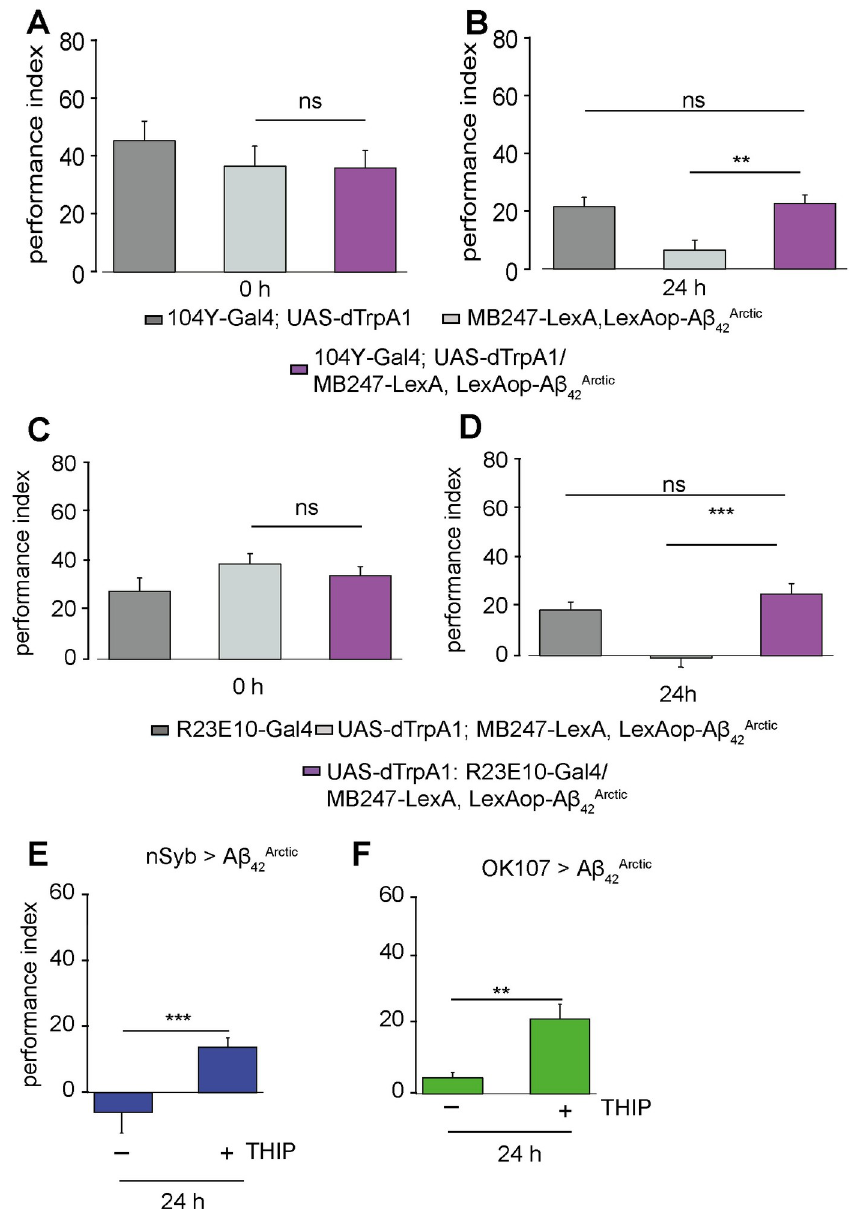
Fig 4. Artificial induction of sleep restores memory impairment in A β 42Arctic expressing flies. (B, D) Flies were transferred to 29˚C after appetitive conditioning to induce sleep by activating dorsal fan-shaped body neurons with dTrpA1 . (A, B) dTrpA1 was expressed with 104y-Gal4 . (A) Performance indices of the 3 tested genotypes were not significantly different from each other immediately after conditioning (n � 7). (B) Inducing sleep for 23 h after conditioning could restore 24-h memory in flies, which express A β 42Arctic in the MB (n � 14). (C, D) Sleep was induced by using R23E10-Gal4 . (C) Directly after conditioning, no significant difference between the tested genotypes was observed (n � 12). (D) 24 h after training, inducing sleep was able to rescue the memory defect of flies expressing A β 42Arctic in the MB (n � 11). (E, F) The drug Gabadoxol (THIP) was used to induce sleep in AD flies. Feeding THIP enhanced LTM tested 24 h after aversive spaced training in flies expressing A β 42Arctic in the brain (E; n � 8) or specifically in the MB (F; n � 8). See S5 Fig for the effect of THIP on sleep and S1 Table for the data. All other details are similar to Fig 1. AD, Alzheimer disease; LTM, long-term memory; MB, mushroom body.